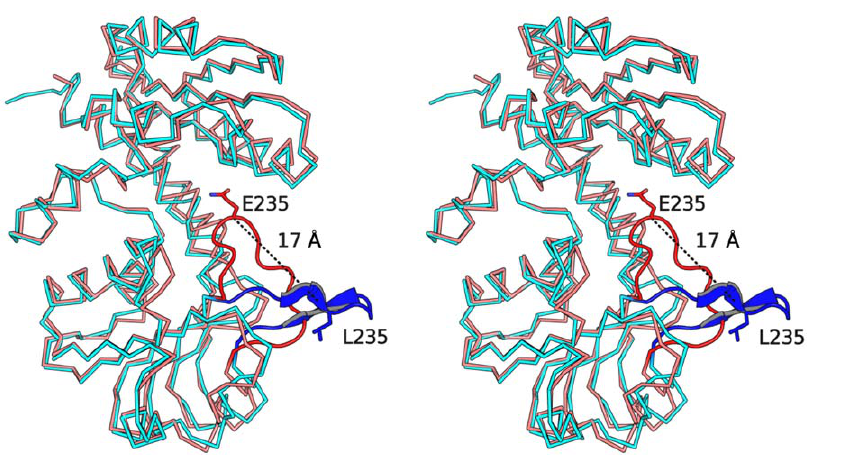
Figure 3. Different loop conformations at the active site. Superposition of a subunit of E.coli FolD (PDB code: 1B0A black) against Pa FolD. A loop in the Pa FolD structure (red residues 231–243) adopts a different orientation compared to the Ec FolD structure (blue) with equivalent residues (Gln235 Pa and Leu235 Ec ) shifting by as much as 16.7 A˚ and an angle of nearly 60 u . In the orientation seen for the Pa FolD structure, the loop sits over the active site.